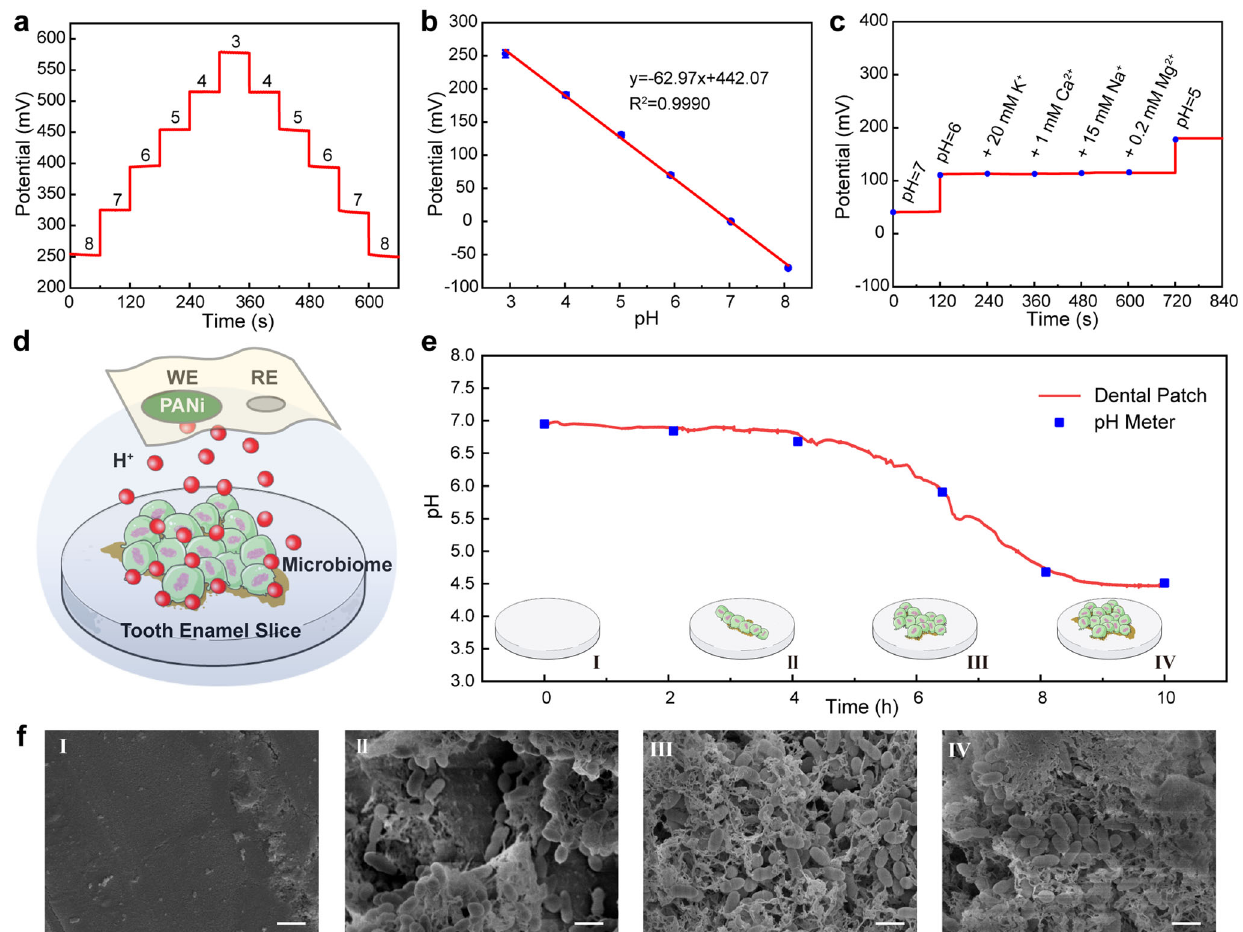
Fig. 3 In vitro evaluation of the electrochemical sensor. a Potential responses of the electrochemical sensor with the pH value changing from 8 to 3. b Linear fi tting curve of the potential response versus pH ( N = 3). Error bars indicated standard deviations. c Selectivity test of the electrochemical sensor with the interferences of K + , Ca 2 + , Na + , and Mg 2 + . d Schematic of the pH monitoring of Streptococcus mutans ( S. mutans ) dental plaque formation process. e The pH monitoring curve (red) of S. mutans dental plaque formation process, with the comparison (blue) of the standard pH meter. The insets showed the schematic of the growing process of dental plaque, including the bare tooth enamel (I), the colonization (II), proliferation (III), and mature (IV) stages of the bacteria. f SEM images of bare tooth enamel slices (I) and S. mutans dental plaque growing on the tooth enamel slices for different times, including 4 h (II), 7 h (III), and 10 h (IV). The images corresponding to the different stages of the growing process of dental plaque. Scale bars, 1 μ